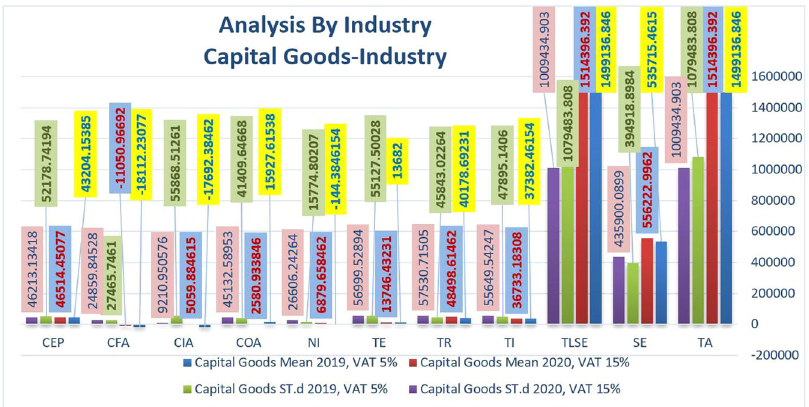
Fig. 5 Comparison of the fi nancial statements' key indicators in term of the average and standard deviation in Capital Goods industry before and after rising VAT.